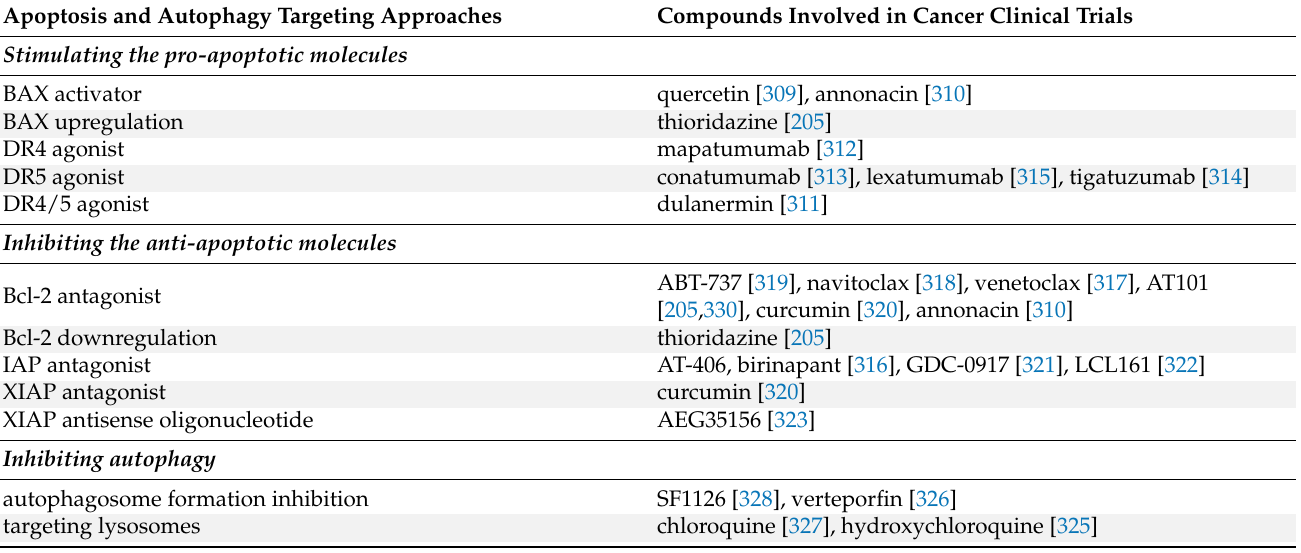
Table 4. Compounds targeting apoptosis and autophagy explored in clinical